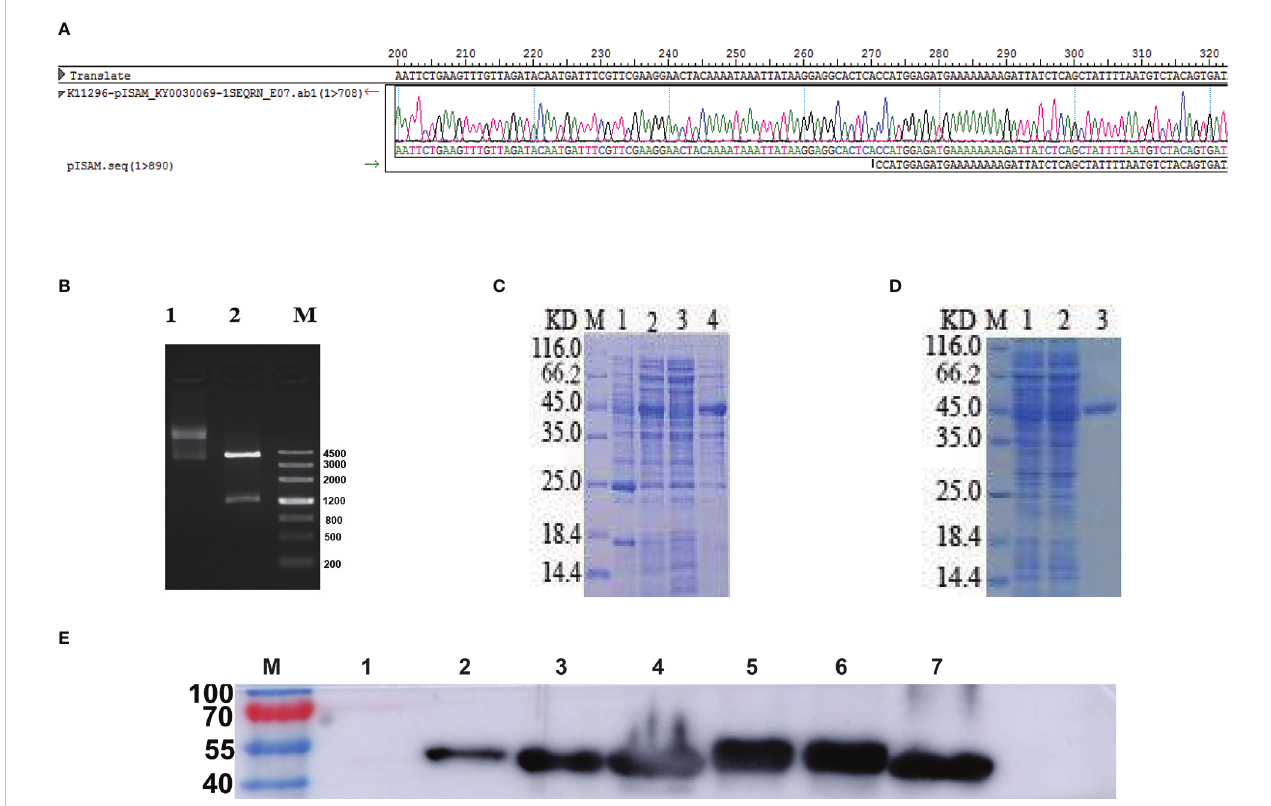
FIGURE 2 Identi fi cation and expression of GILE proteins. (A) : Observed and expected sequences of pCzn1-GILE. (B) : Enzyme digestion of pCzn1-GILE (M: Mark; Line1: before enzyme digestion; Line2: after enzyme digestion). (C) : Identi fi cation of GILE protein expression by SDS-PAGE (M: Mark, Lane 1: uninduced Escherichia coli expressing GILE proteins, Lane 2: induced Escherichia coli expressing GILE proteins, Lane 3: supernatant inducted with IPTG, Lane 4: precipitate inducted with IPTG). (D) : SDS-PAGE results of GILE protein puri fi cation (M: Mark, Line 1: samples after crushing, Line 2: samples discharged in puri fi cation, Lane 3: Puri fi cation). (E) : Western blot results (Lane 1: uninduced Escherichia coli expressing GILE proteins; Lane 2: induced Escherichia coli expressing GILE proteins; Lane 3: supernatant of induction with IPTG; Lane 4: precipitation of induction with IPTG; Lane 5: supernatant of inclusion-body